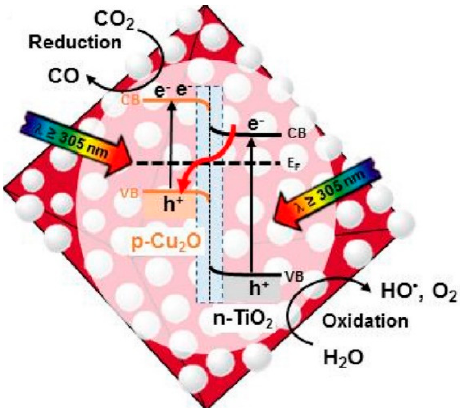
Figure 5. Proposed operative mechanism for the reduction of CO 2 ( g ) into CO( g ) during UV–visible irradiation at λ ≥ 305 nm of an octahedral Cu 2 O/TiO 2 nanocomposite in the presence of H 2 O( g ). Adapted with permission from reference [21].